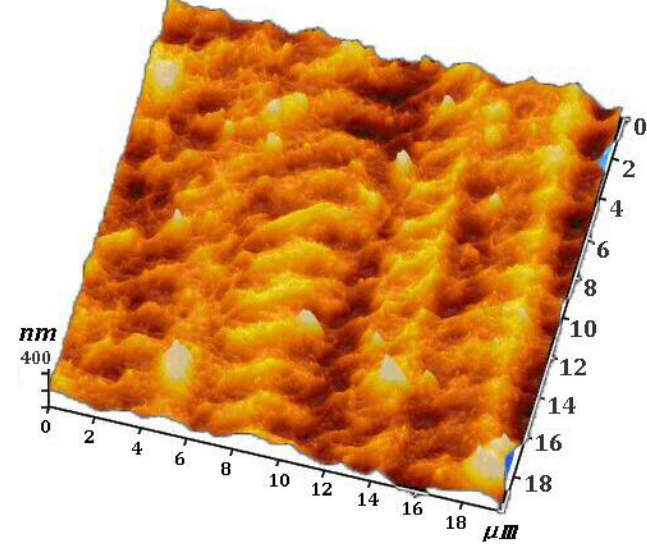
Figure 5. Three-dimensional (3-D) microscope image of UNSMed Surface feature by atomic force microscope (AFM).